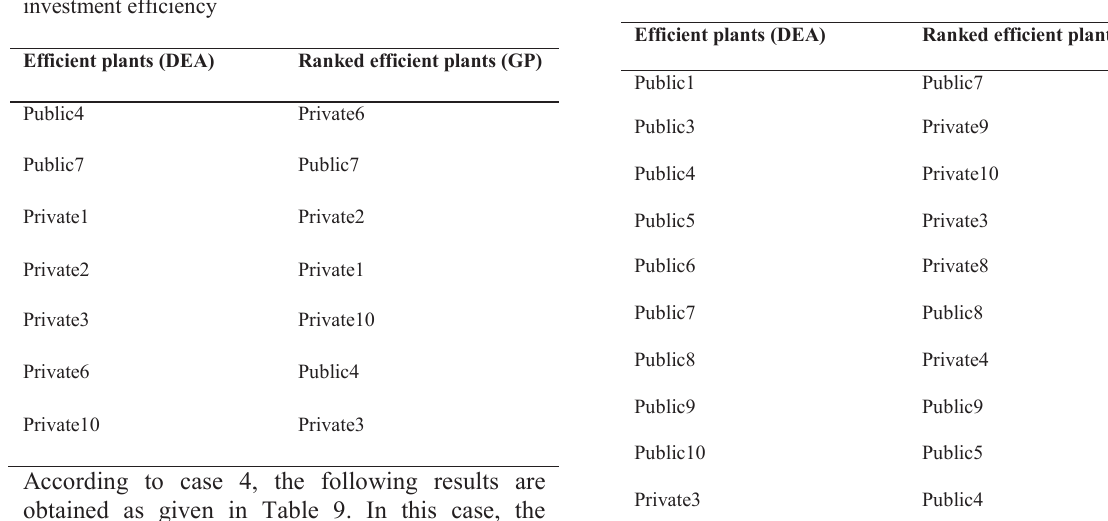
Table 9. Ranking of power plants according to the operational and investment efficiency